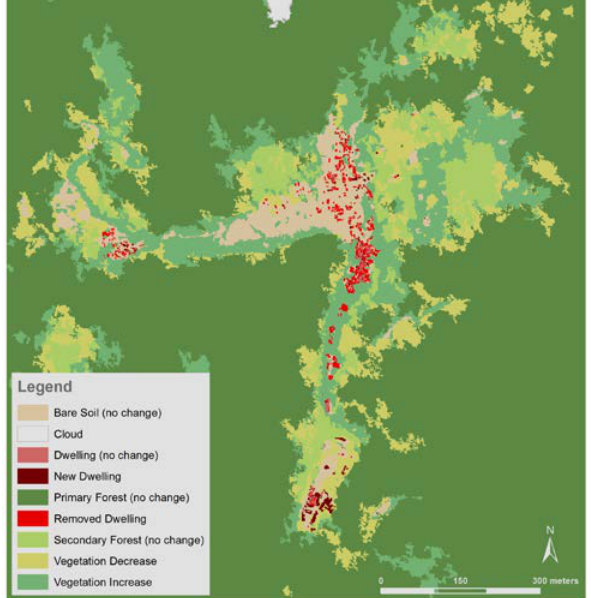
Fig. 5 . Results of the land cover change from September 2010 to June